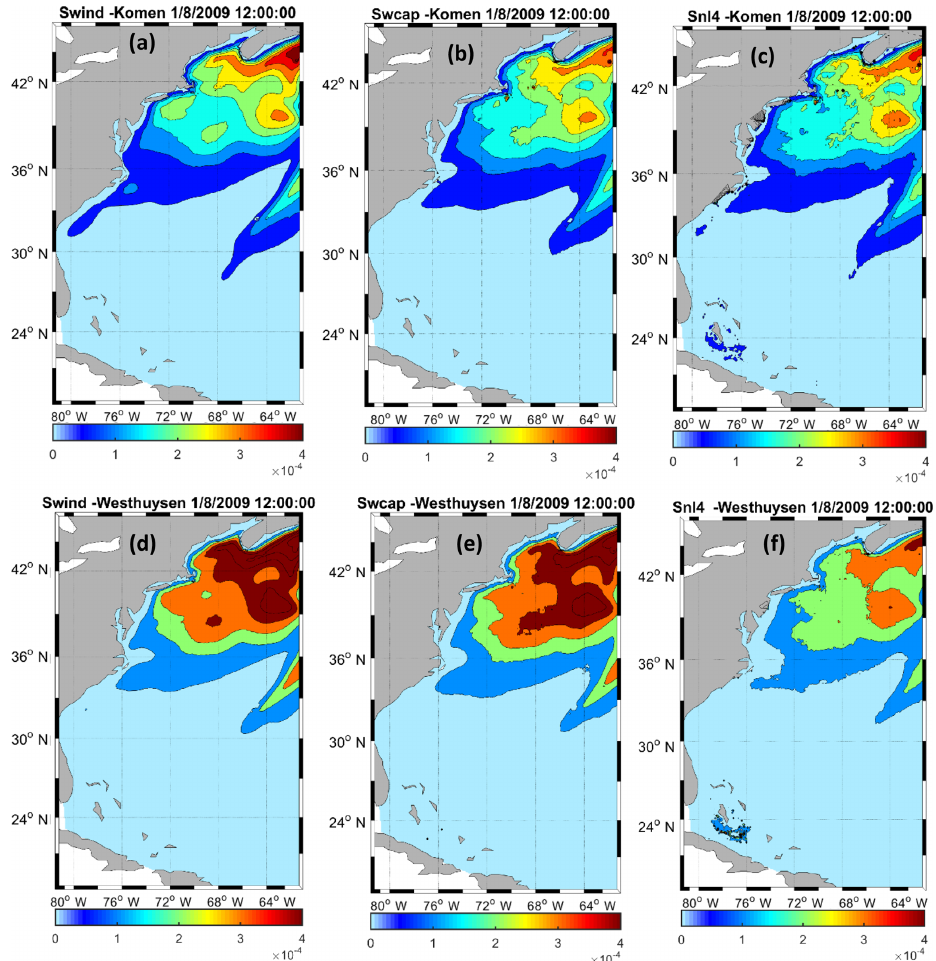
Figure 11. Spatial variations of source terms (wind input, whitecapping dissipation, and quadruplet in m 2 s − 1 ) integrated in the spectral domain over the modeling area at time t1, for (a–c) Komen and (d–f)